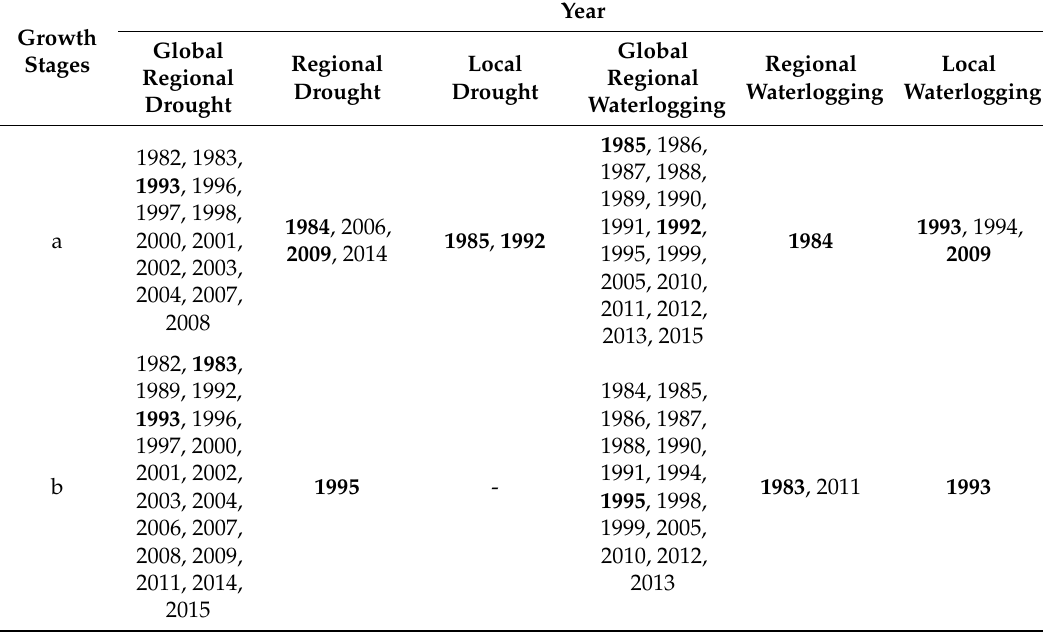
Table 4. Years of drought and waterlogging in di ff erent growth stages for maize in Midwestern Jilin Province. ( a – c ) Represent the stages of emergence-tasseling stage, tasseling-milky maturity, and milky maturity-mature,